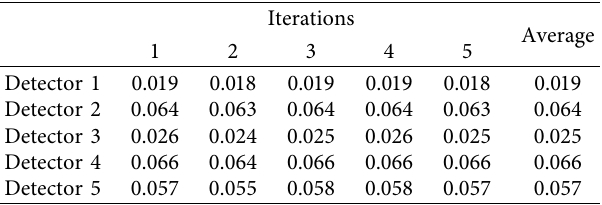
Table 2: Comparison of U-values between field and simulation